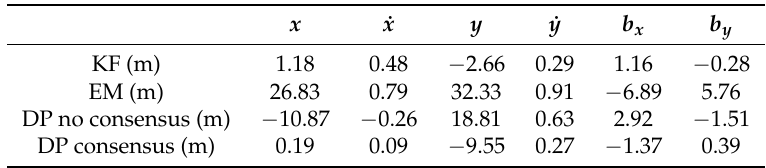
Table 3. Comparison of mean estimation error